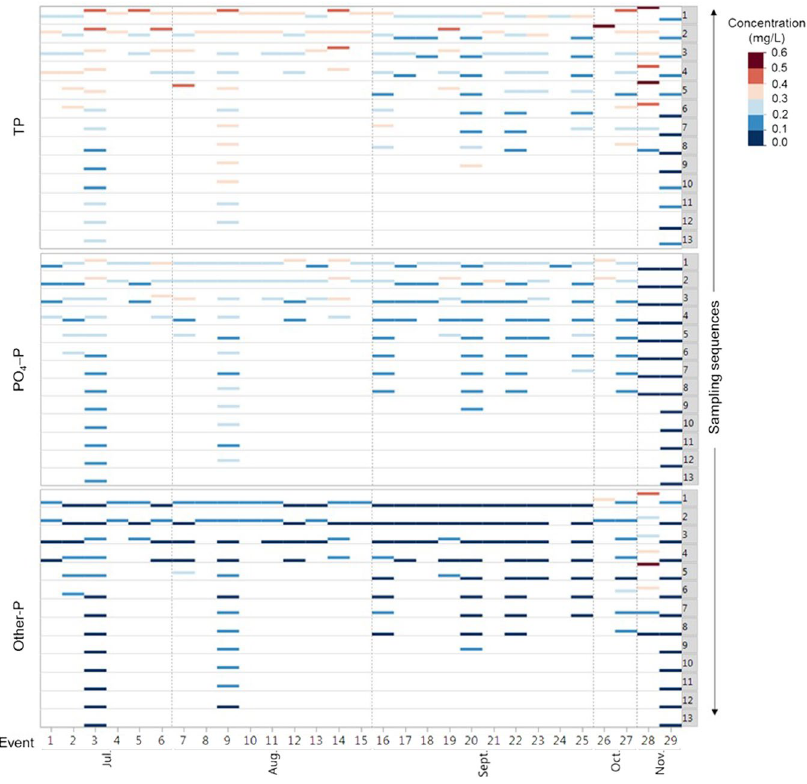
Figure 1. Heatmap showing concentration of TP, PO 4 –P, and other–P in the stormwater runoff (n = 153) from 29 individual storm events during July–November 2014 with sampling sequences 1 to 13, which refer to individual samples collected in 5-minute intervals during each event.